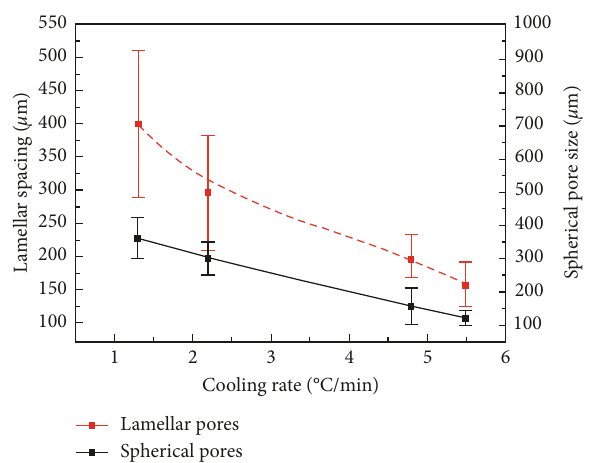
Figure 5: Influence of cooling speed on the average lamellar spacing and the spherical pore